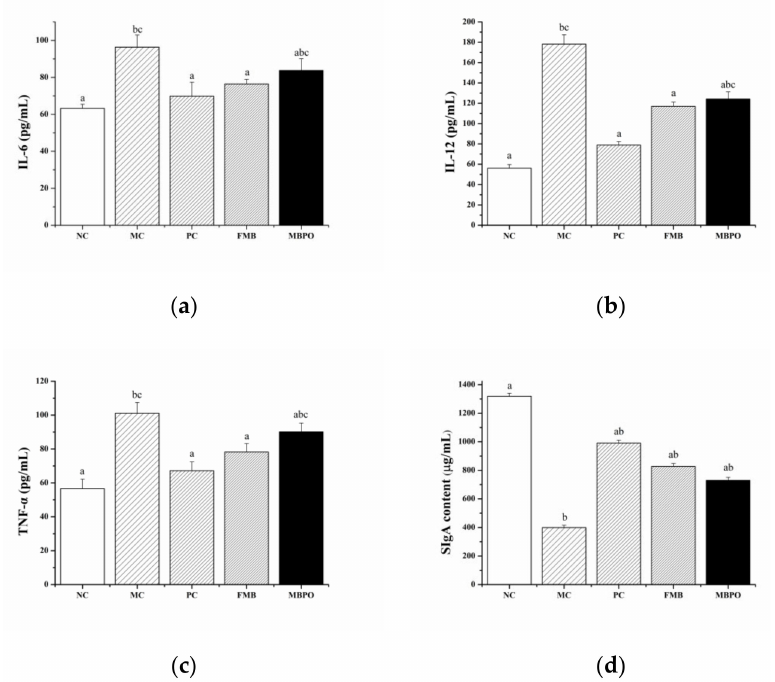
Figure 5. Effects of fermented millet bran on the expression of inflammatory cytokines ( a ) IL-6, ( b ) IL-12, and ( c ) TNF- α and intestinal mucosa ( d ) SIgA in mice. a p < 0.05 vs. MC group, b p < 0.05 vs. NC group, c p < 0.05 vs. PC